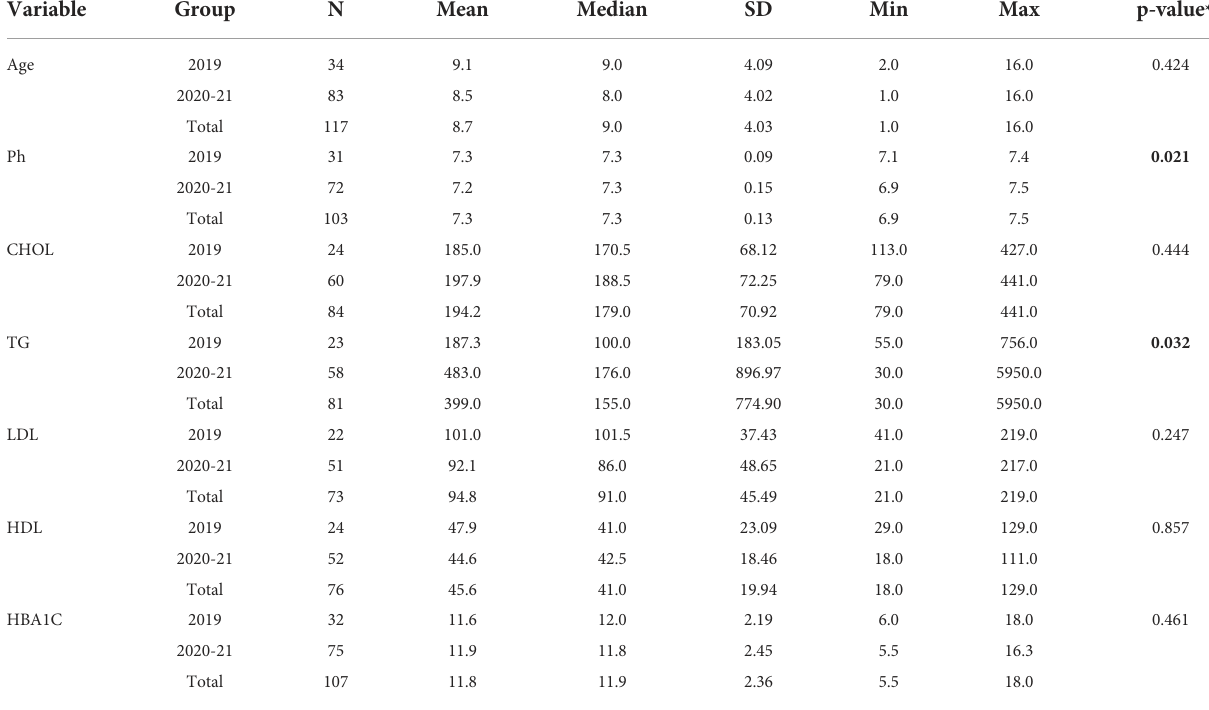
TABLE 3 Spearman correlation coef fi cient results between blood Ph and Triglycerides for the whole period and separately for each period.